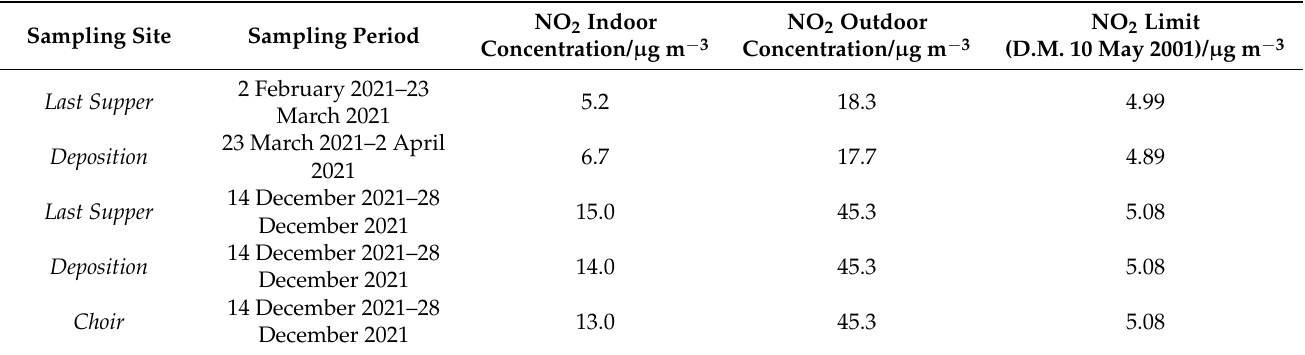
Table 6. Nitrogen dioxide concentrations inside the Sanctuary compared with the outdoor values and recommended